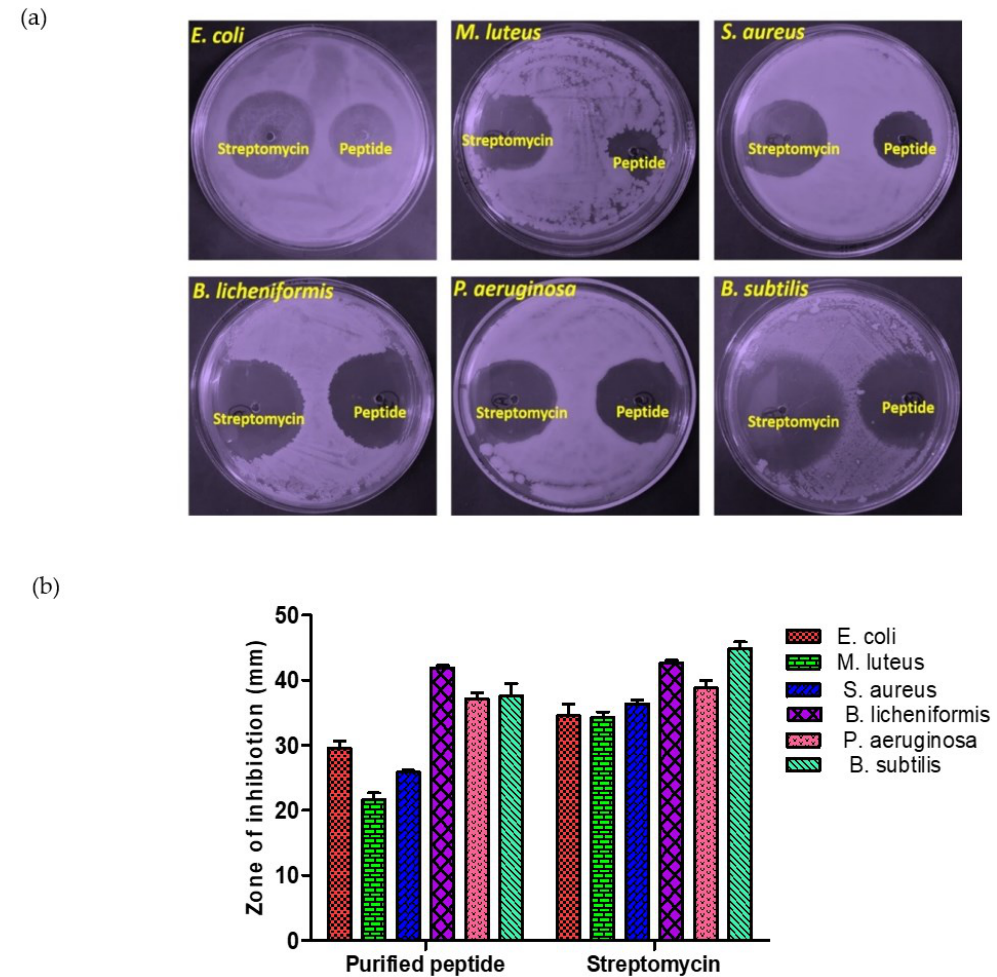
Figure 10. Antimicrobial activity of chickpea peptide ( a ) towards various human pathogen ( b ) zone of inhibition.